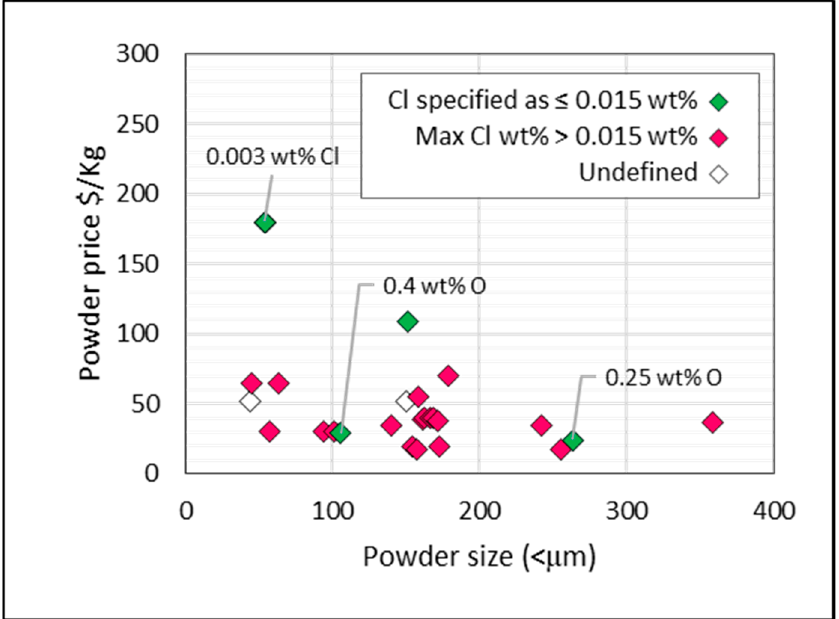
Figure 16. Price per kg of titanium powder (HDH and sponge fines) versus powder size (< μ m). Chlorine content indicated by color.